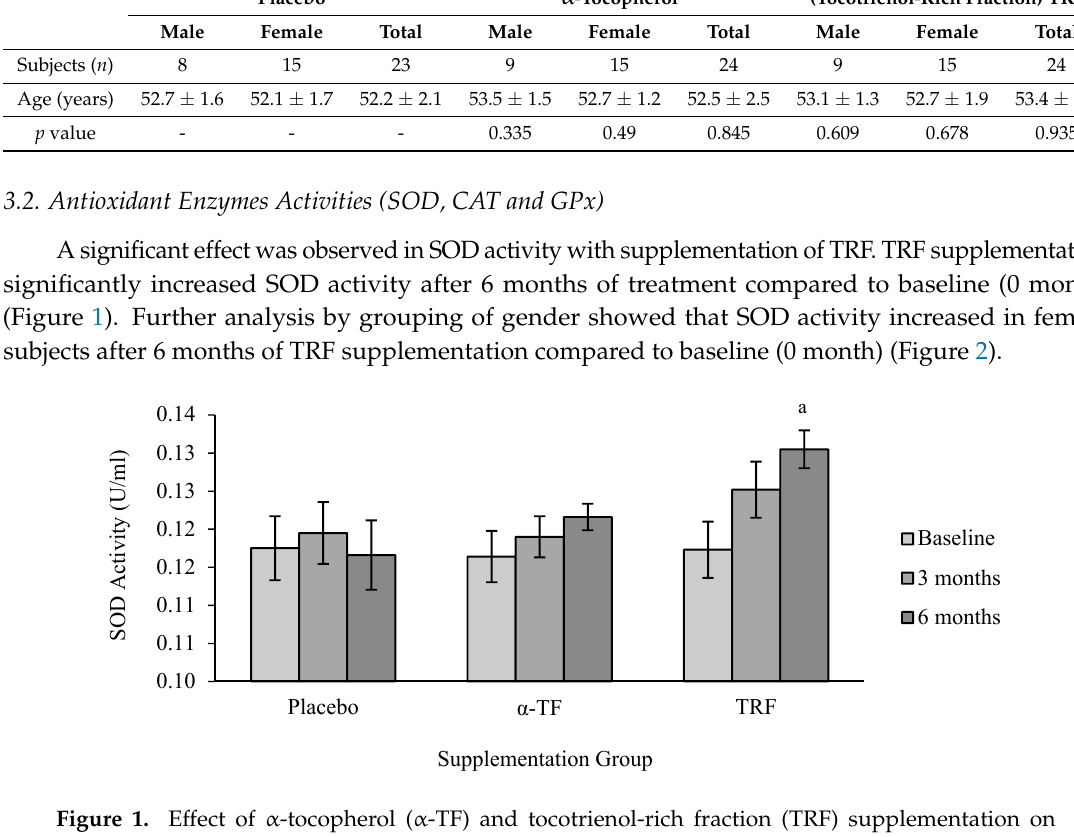
Table 1. Baseline and intervention characteristics of the subjects.